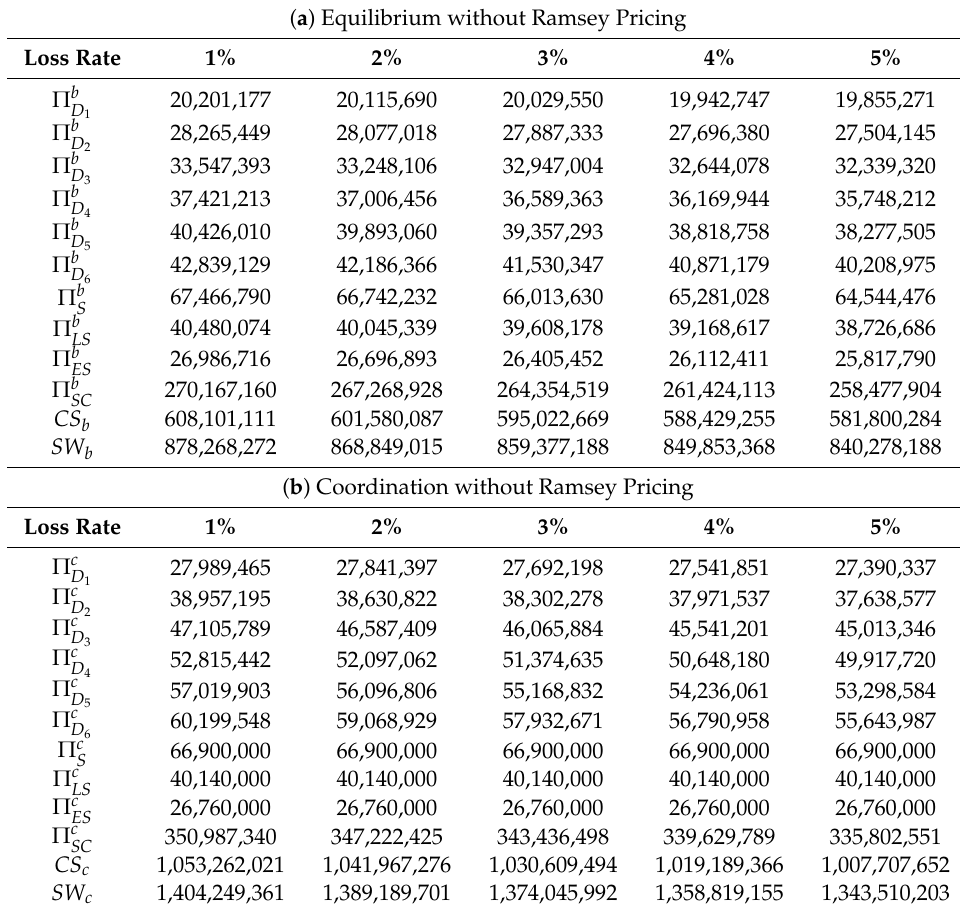
Table 7. Sensitivity analysis Results of Water Delivery Loss